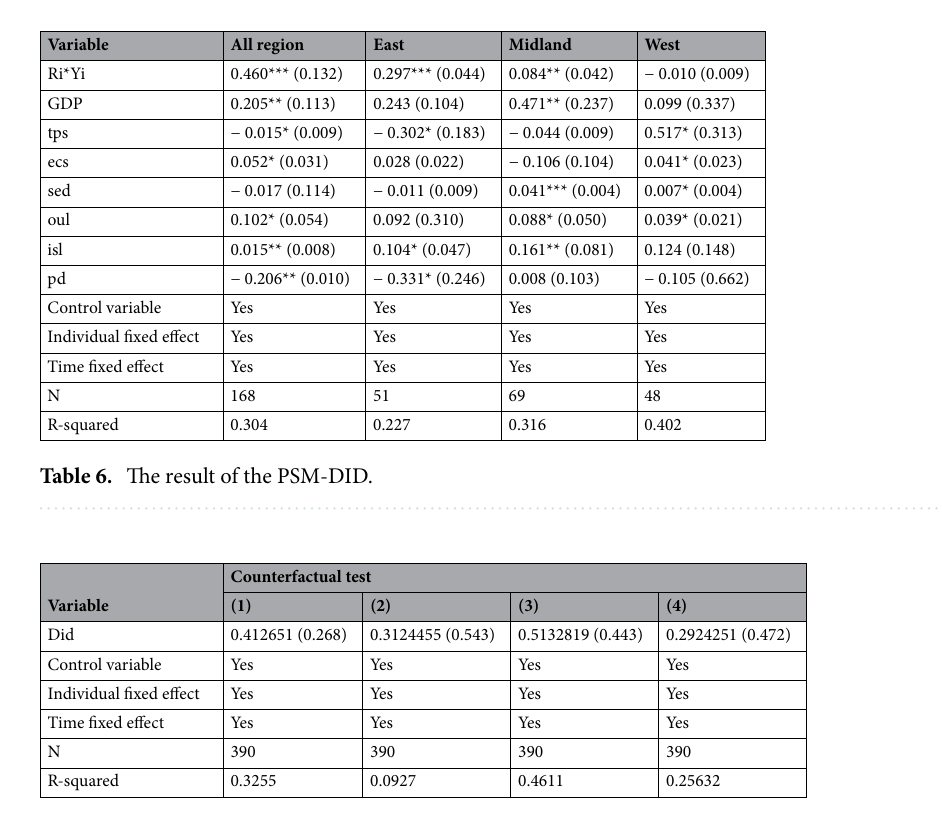
Table 7. Counterfactual test